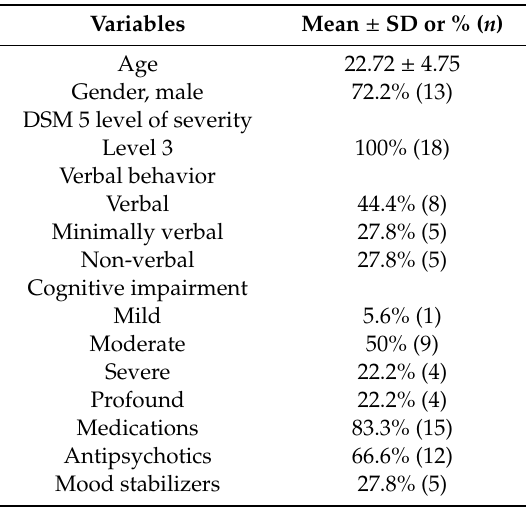
Table 1. General characteristics of the